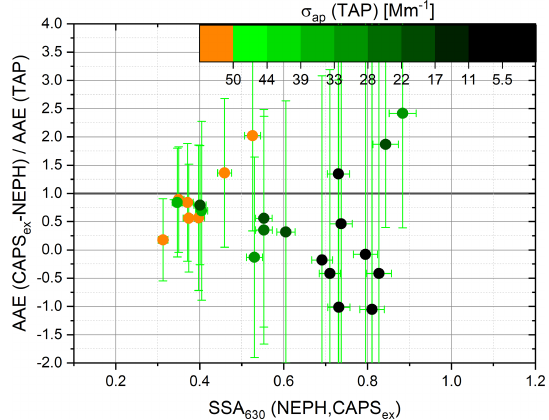
Figure 14. The absorbing Ångström exponent ratio, AAE(CAPS, NEPH)/AAE(TAP), as a function of 630nm wavelength SSA(NEPH, CAPS) values for AQ–AS mixtures. The 630nm wavelength light-absorption coefficient, σ ap (TAP), is used as the colour code. Measured precision error bars are shown for individual